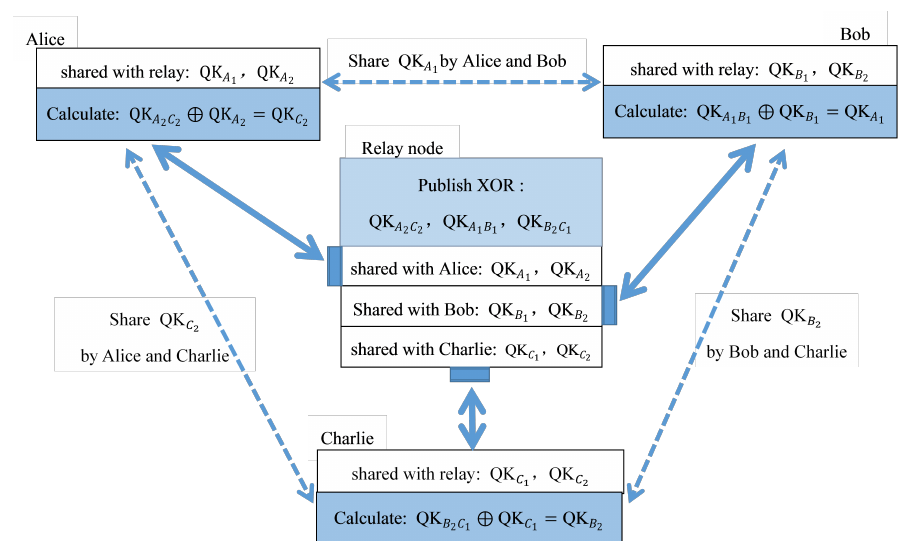
Figure 4. The QKD network scheme with three endpoints based on the public-XOR-key scheme. The solid arrow stands for the QKD process. The dotted arrow indicates the key shared by each pair of endpoints. Relay node calculates and publishes Qk A = Qk ⊕ Qk Qk B B 2 C 1 , and then dismisses the QKD keys immediately. Finally, Alice and Bob 2 C 1